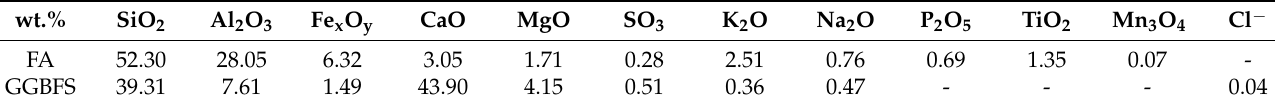
Table 1. Oxide composition of fly ash and ground granulated blast furnace